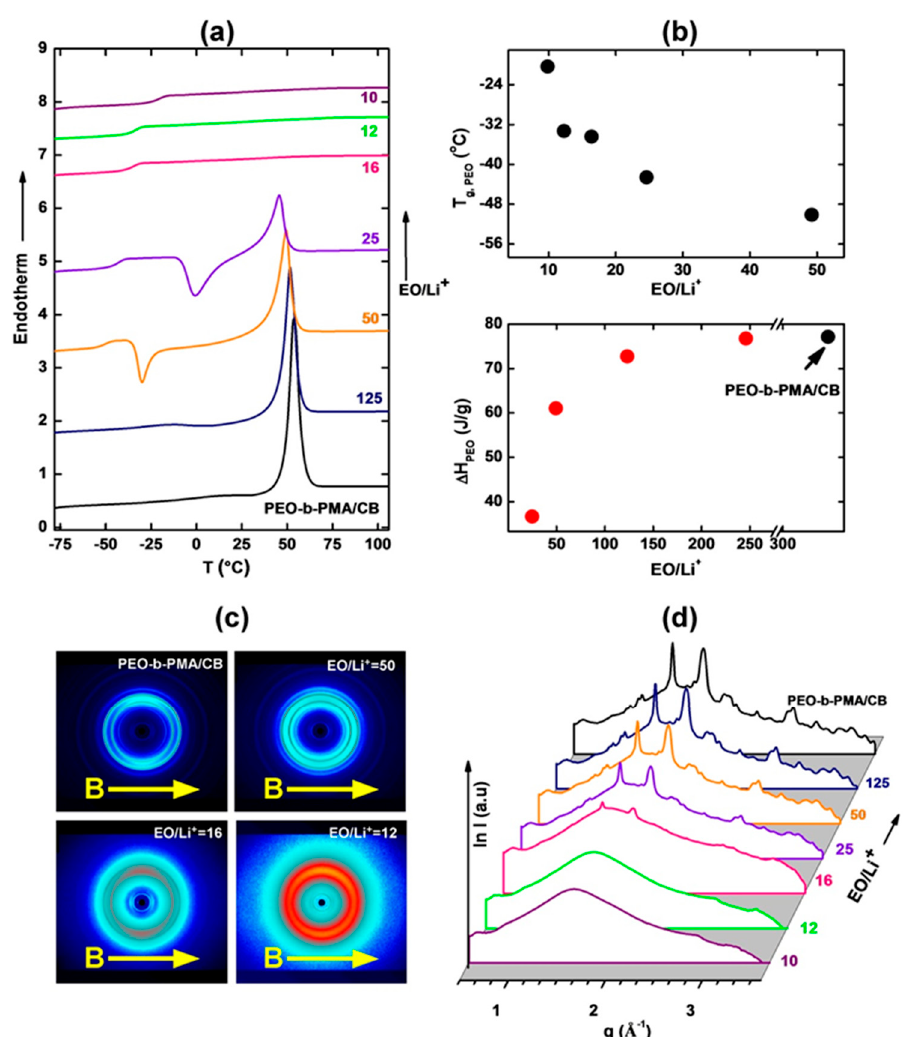
Figure 3. ( a ) DSC data of the PEO-b-PMA/CB system at different Li-doping levels as indicated ( b ) Corresponding glass transition temperature of PEO and PEO melting enthalpy of the system. Data clearly indicate a glass transition temperature increase and suppression of PEO crystallization with the inclusion of Li + . The DSC data are corroborated by the 2D WAXS data shown in ( c ). ( d ) Circularly integrated WAXS data for different EO:Li + ratios. PEO diffraction peaks display uniform azimuthal distribution indicating lack of preferential orientation of the PEO chains in the field-aligned samples.